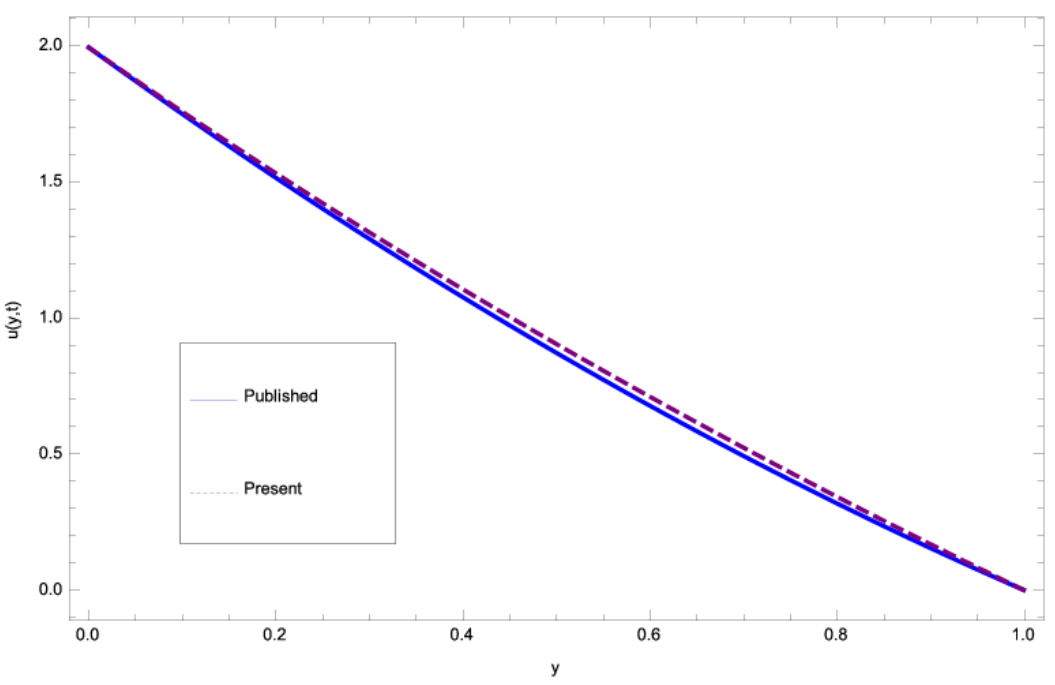
Figure 13. The comparison of the velocity profile of the present work and published work [18], when